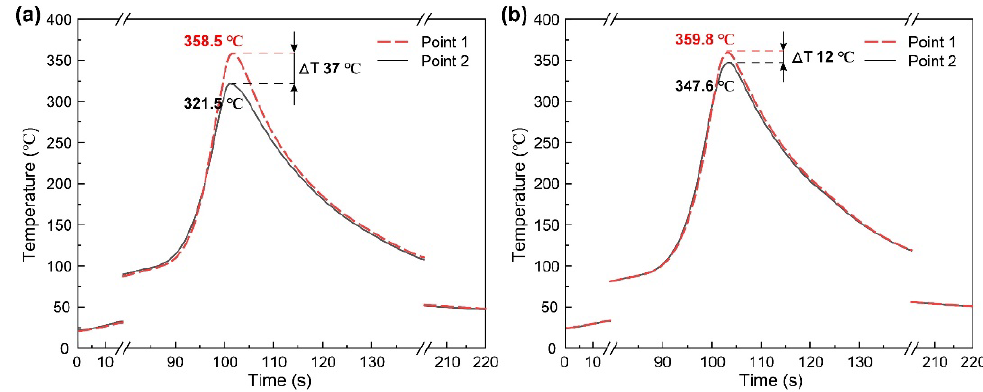
Figure 6. Temperature curves at different positions of ( a ) Pin-1-400-200 and ( b ) Pin-2-400-200.